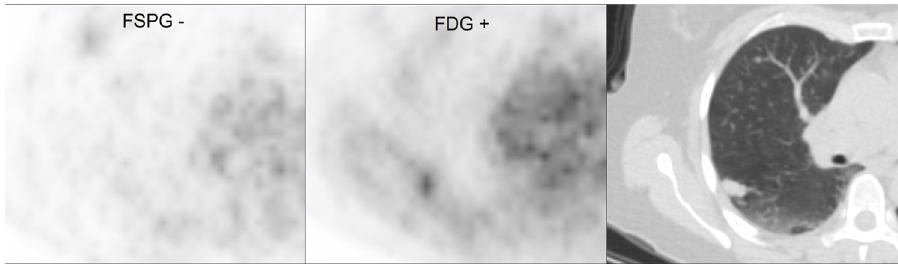
Fig 5. Subject with negative 18 F-FSPG (SUVmax 0.9) and positive 18 F-FDG (SUVmax 2.4) PET/CT.